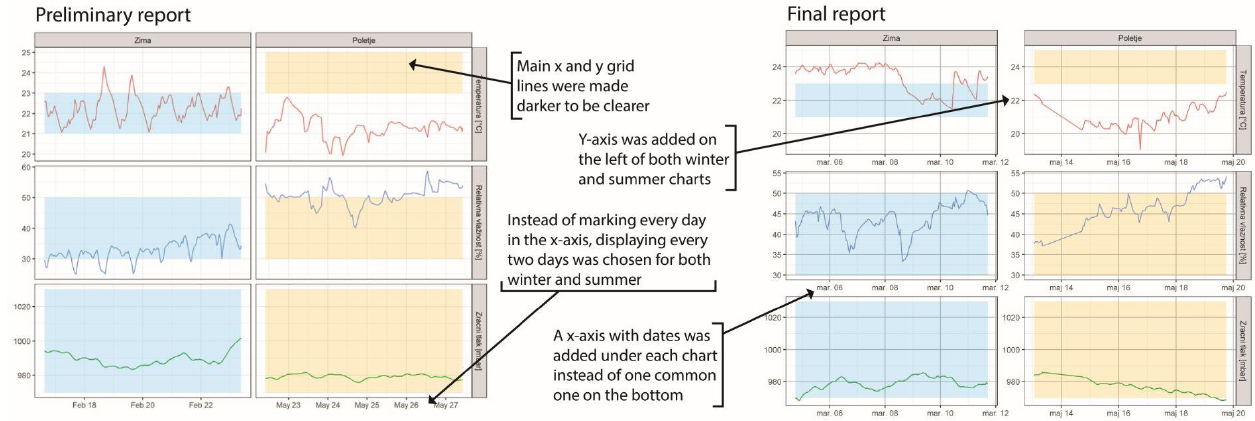
Figure 2. Example of adjustments to the visualisation based on the focus group discussions. Final figure caption: “Meteorological conditions in one household during the winter ( left ) and summer ( right ) campaigns. The top plot displays temperature, followed by relative humidity and air pressure. Optimal ranges for all three parameters are also displayed and coloured in yellow (summer) and blue (winter) ” .